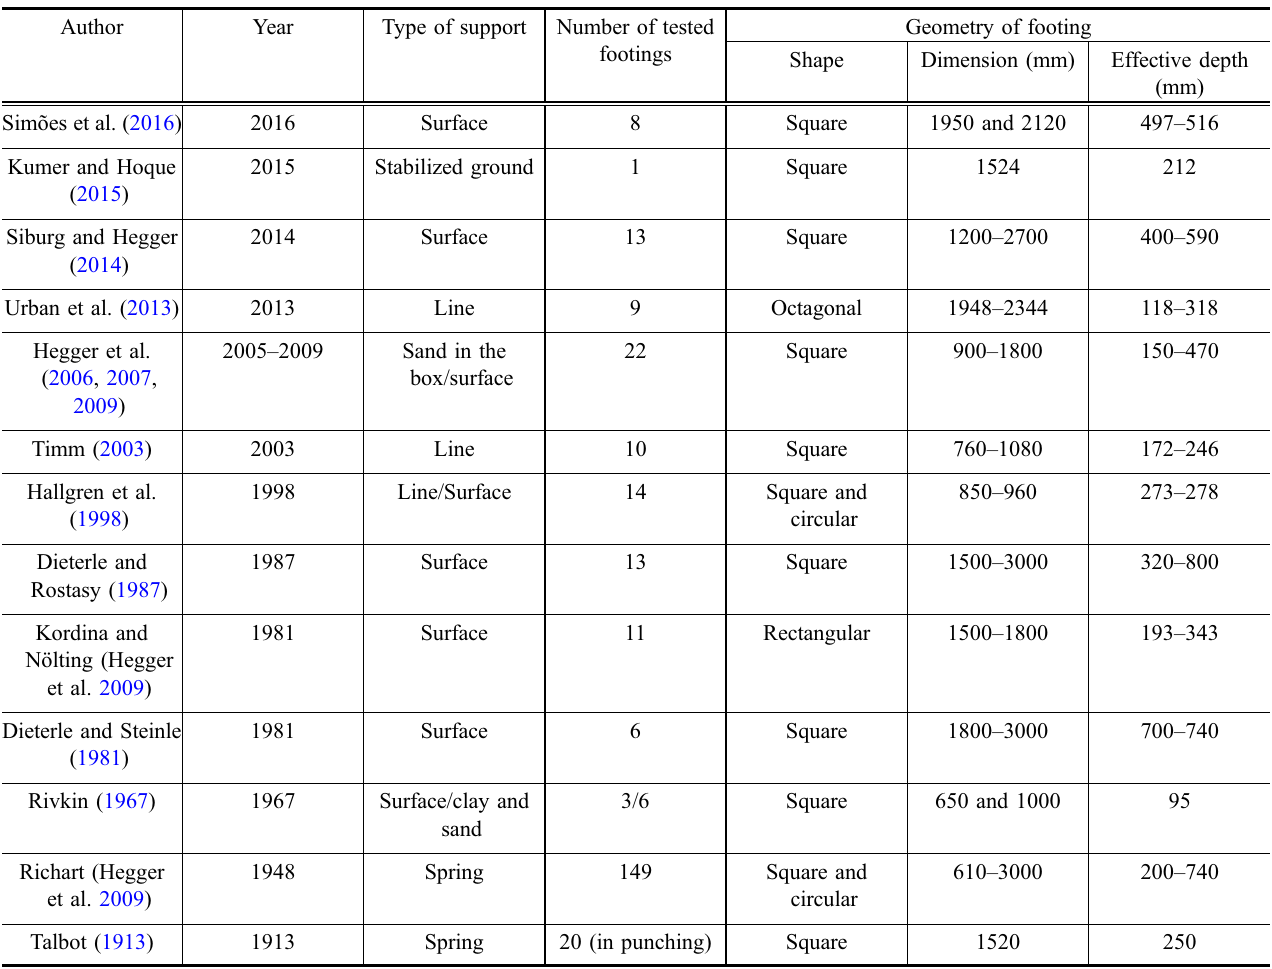
Table 1 Overview of previous experiments on column